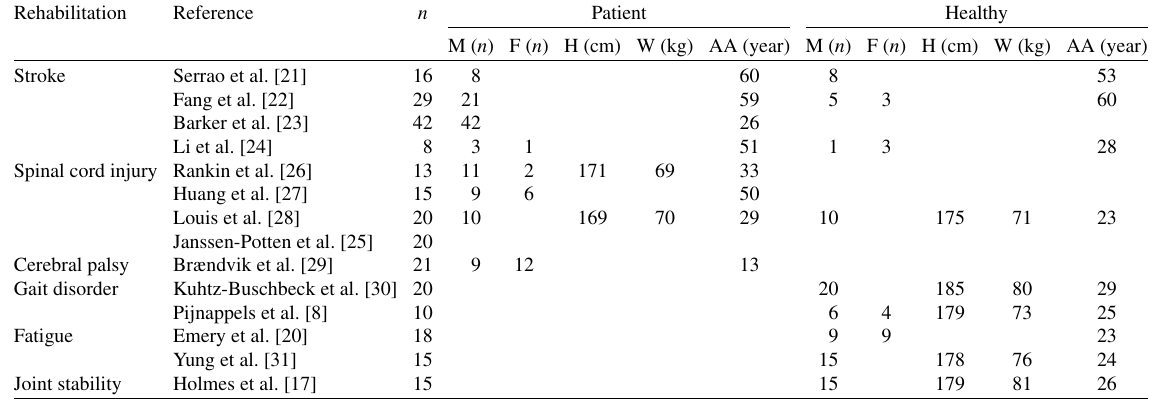
Table 2 Summary of the anthropometric variables of the participants used in the rehabilitation-based studies